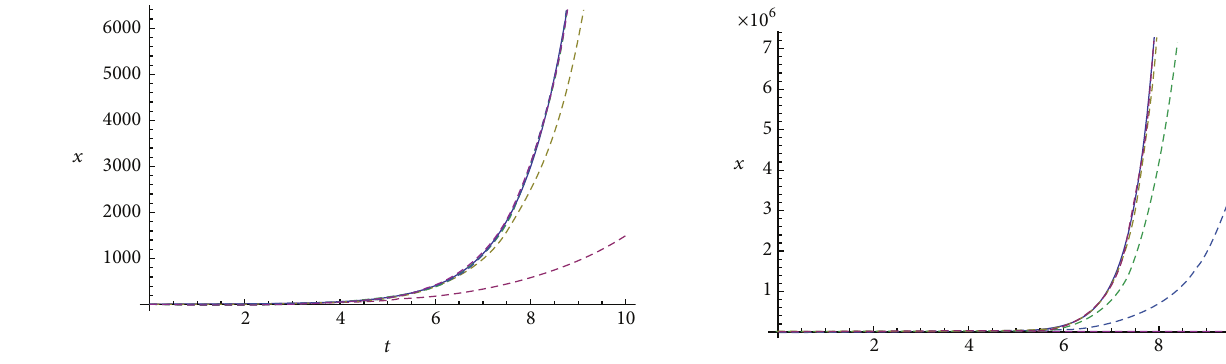
(𝑡) and Figure 2: Plots of the exact solution 𝑥 2 (𝑡) and the RPS solutions 1 (𝑡) , 𝑘 = 5, 10, 15, 20 , for (33) and (34) on [0, 10] , where 𝑥 𝑥 𝑘 2 𝑥 𝑘 (𝑡) are represented, respectively, by straight and dashed lines. 2